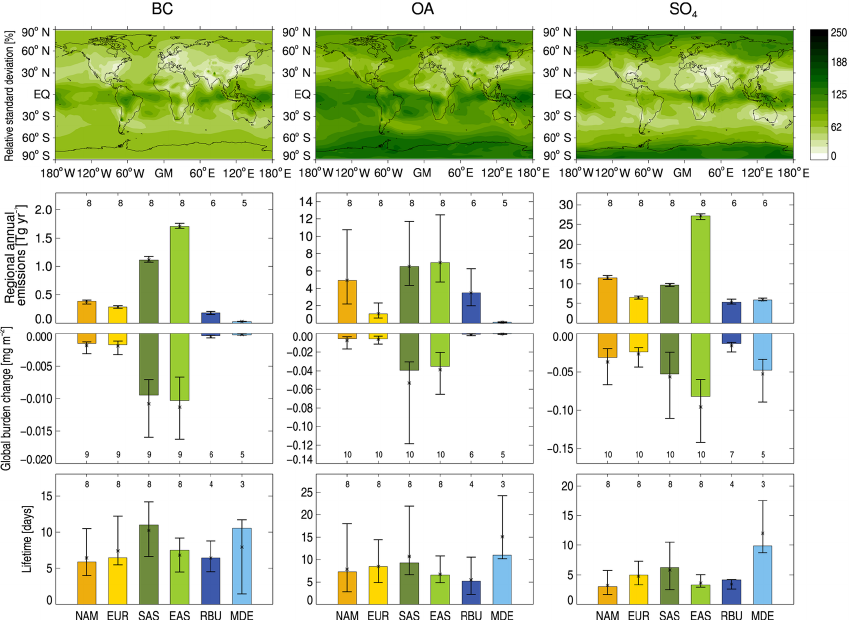
Figure 2. Top row: relative inter-model standard deviation in annual mean aerosol emissions. Second row: regionally averaged annual mean aerosol emissions (for SO 4 , we give SO 2 emissions, in TgSO 2 ) , for the source regions shown in Fig. 1. Numbers are from the BASE simulations. Error bars show the maximum and minimum emissions for the sample of models used here, and the numbers above the bars give the number of models that have data for the given value. Third row: globally and annually averaged aerosol burden change for 20% emission reductions in the indicated region. Numbers are from the perturbation simulations. Bottom row: aerosol lifetime, here defined as the global change in burden divided by the global change in emissions following an emission reduction within a given source region (see main text, Eq. 4).